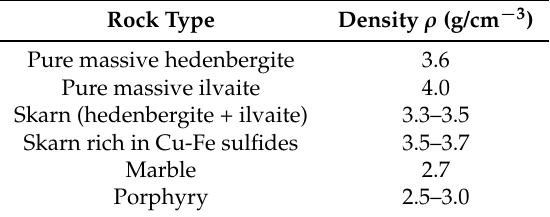
Table 1. Typical densities of the rocks present in the mine.